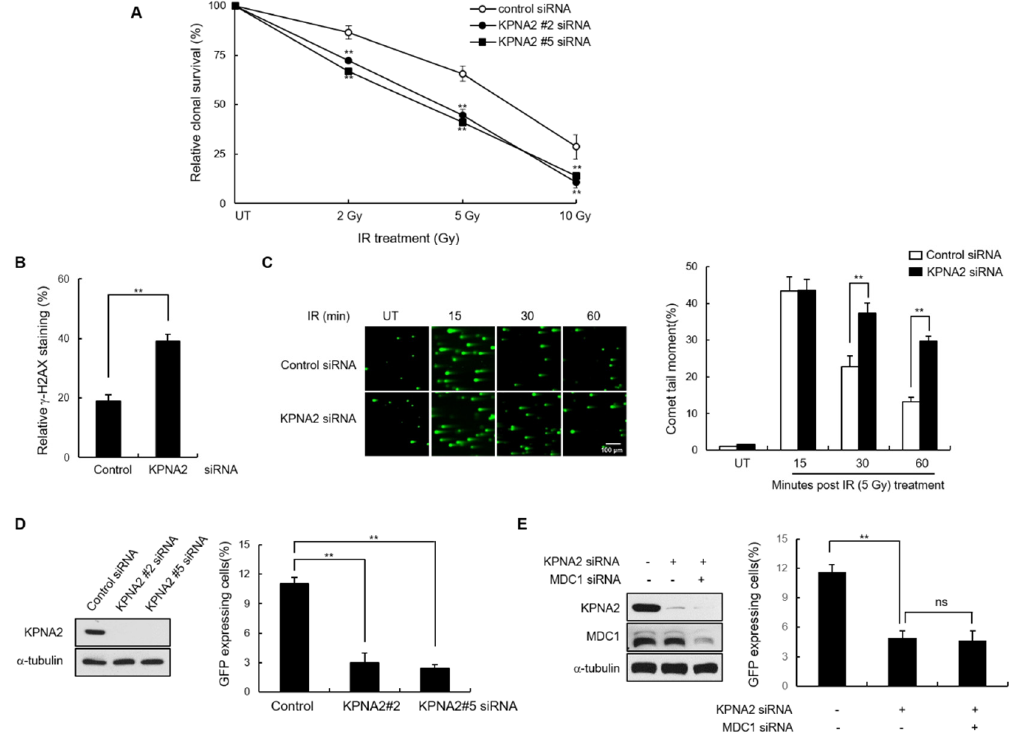
Figure 5. KPNA2 promotes HR repair. ( A ) Control and KPNA2-depleted HeLa cells were exposed to the indicated dose of IR and assessed for colony forming ability. The cell viability of untreated cells is defined as 100%. Data presented as mean ± s.d. ( B ) Control and KPNA2-depleted HeLa cells were exposed to IR. After 24 h, immunostaining was performed using γ -H2AX antibody. The percentage of cells containing > 10 γ -H2AX foci was then calculated. Data are presented as means ± s.d. ( C ) Control and KPNA2-depleted HeLa cells were untreated or treated with 5 Gy γ -irradiation. At the indicated time points, cells were harvested to carry out comet assay under neutral condition. Comet images were captured using fluorescence microscopy, and comet tail moment was analyzed using Komet 5.5 analysis software. Representative comet images obtained at different time points are shown. Scale bar; 100 µ m. Changes in the tail moments between control and KPNA2 knockdown cells after IR treatment are represented in histogram. Data presented as mean ± s.d. ( D , E ) DR-GFP-U2OS cells transfected with the indicated siRNA combinations. The level of endogenous KPNA2 and MDC1 were analyzed by Western blotting (left). The GFP-positive cells were measured by Fluorescence-activated cell sorting (FACS). Data represent mean ± s.d. ( n = 3), ** p < 0.01. ns, not significant.